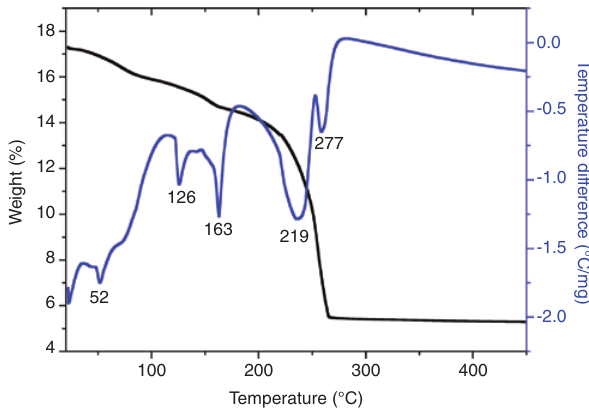
Figure 3: TGA and DTA of the diagram of the grinded mixture.